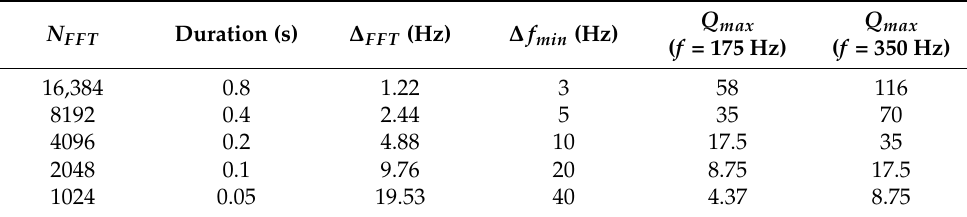
Table 1. Maximum quality factors depending on the frequency resolution and the central frequency (sampling frequency: f s = 20 kHz, N FFT : number of points in the FFT, ∆ FFT : frequency step). N FFT Duration